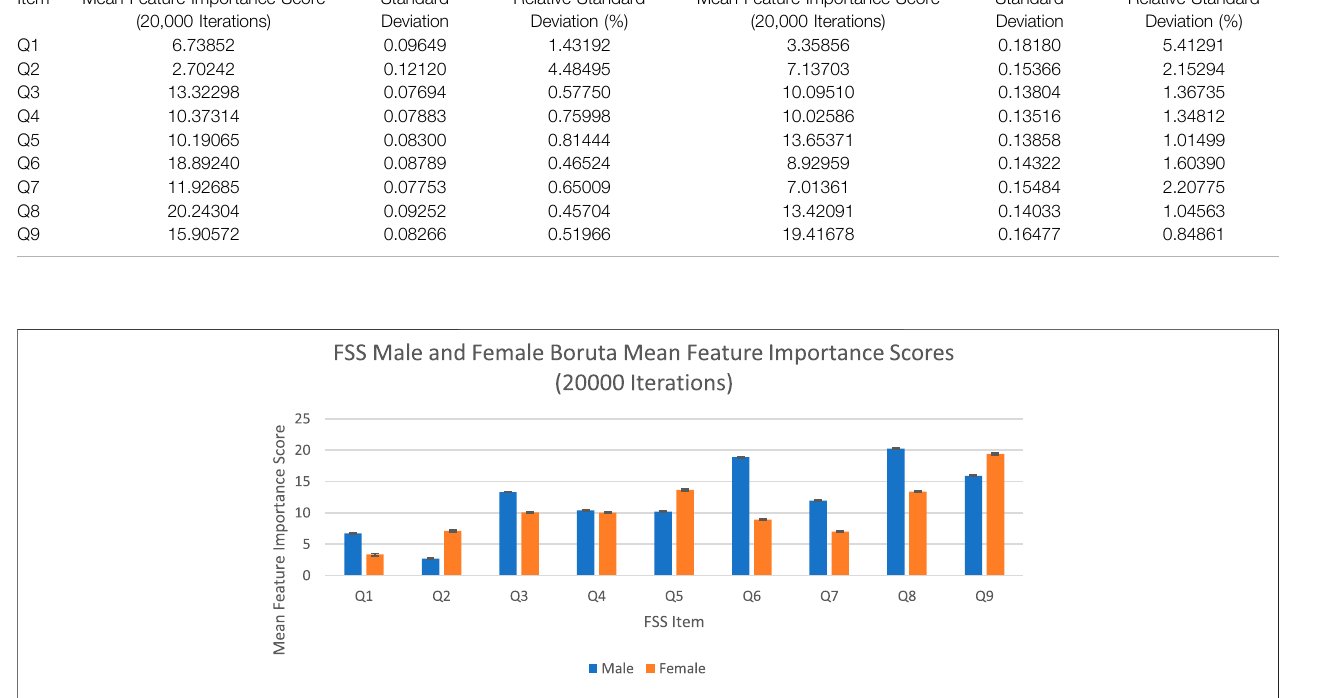
TABLE 3 | FSS male and female Boruta mean feature importance scores for 20,000 iterations. FSS male Boruta FSS female Boruta Item